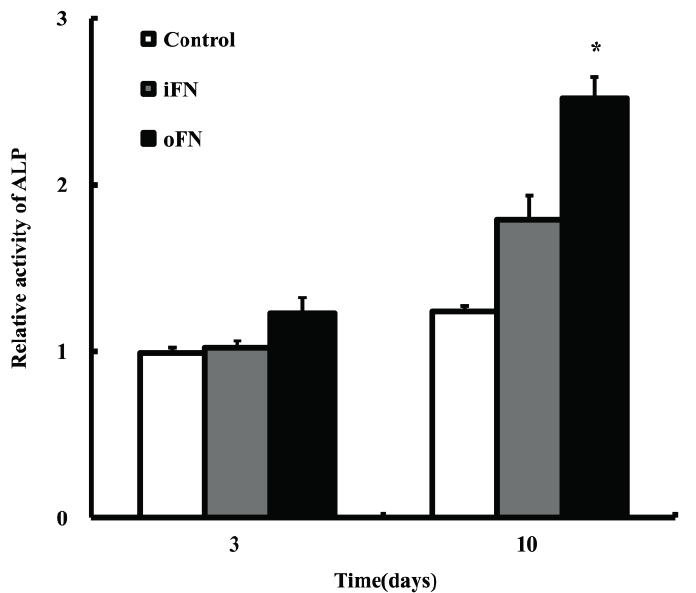
Figure 3. Alkaline phosphatase (ALP) activity of osteoinductive fibronectin (oFN, 5 μ g·mL − 1 ) on MC3T3-E1 cells, at 3 and 10 days. Cells were seeded at a density of 1 × 10 3 cells/well on plates coated with integrin-binding fibronectin (iFN) or oFN and incubated. Non-treated cells were used as control. ALP activity was normalized versus control and is represented as mean ± standard deviation ( n = 3). * p < 0.05 compared with iFN-loaded groups or